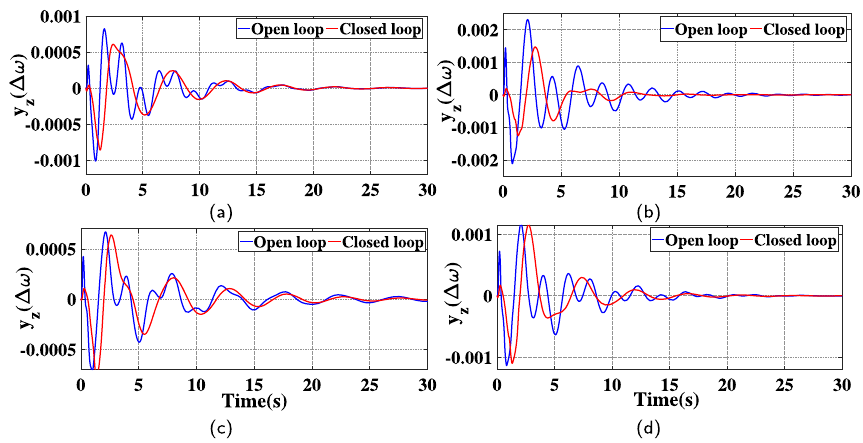
Fig. 5 Dynamic response of system with WRDC(CL) versus without WRDC(OL) under different operating conditions. a At nominal operating point(Tie-line power flow of 400MW) ( b ) Under one of the tie-line outage ( c ) Tie-line power flow of 700MW ( d ) Tie-line power flow of 100MW